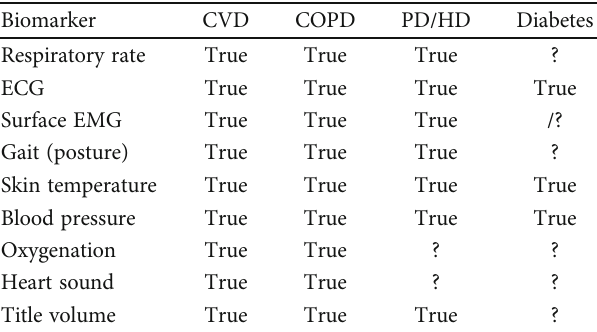
Table 1: List of future and available sensors and their applications for detecting patient behavioral